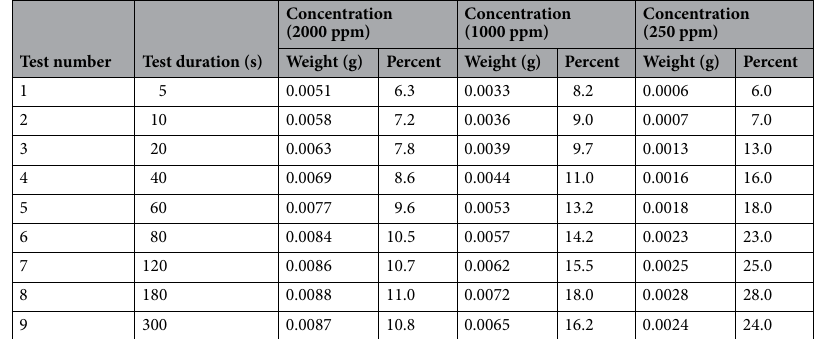
Table 8. Asphaltene deposition rate for PTFE coated electrode in dynamic state for different asphaltene concentrations and exposure time to electric field. Deposition value (electric field strength 2 kV/cm, 4% toluene concentration, PTFE coating, dynamic